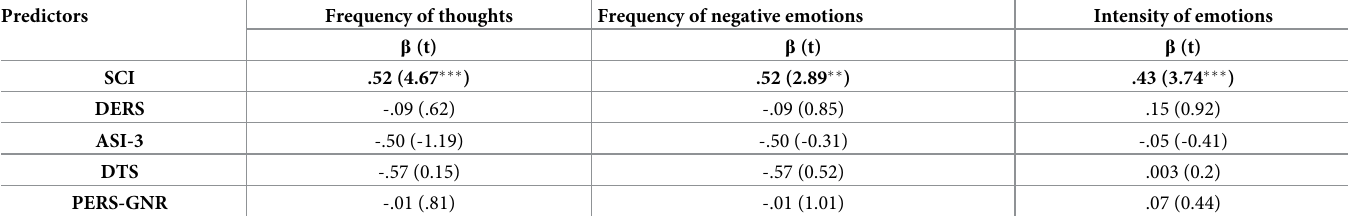
Table 4. Linear regression models considering the frequency of thoughts and negative emotions, and the intensity of emotions related to the object expressed dur- ing the week. Predictors